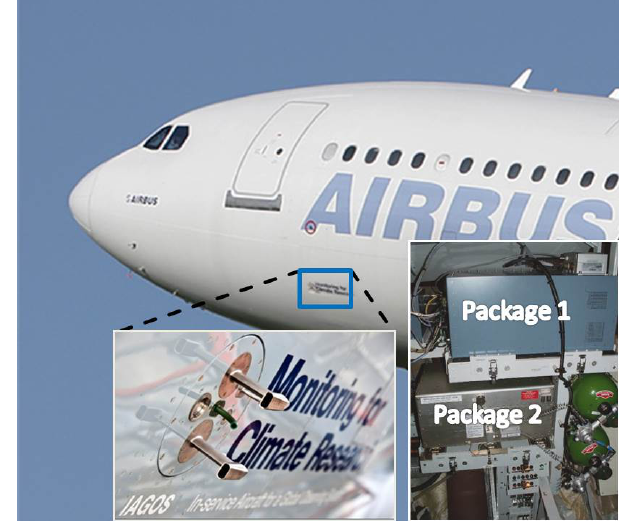
Figure 1. Position of Package 1 and Package 2 installed aboard the Airbus A340-300. The inlet plate including the Rosemount housing is attached at the aircraft